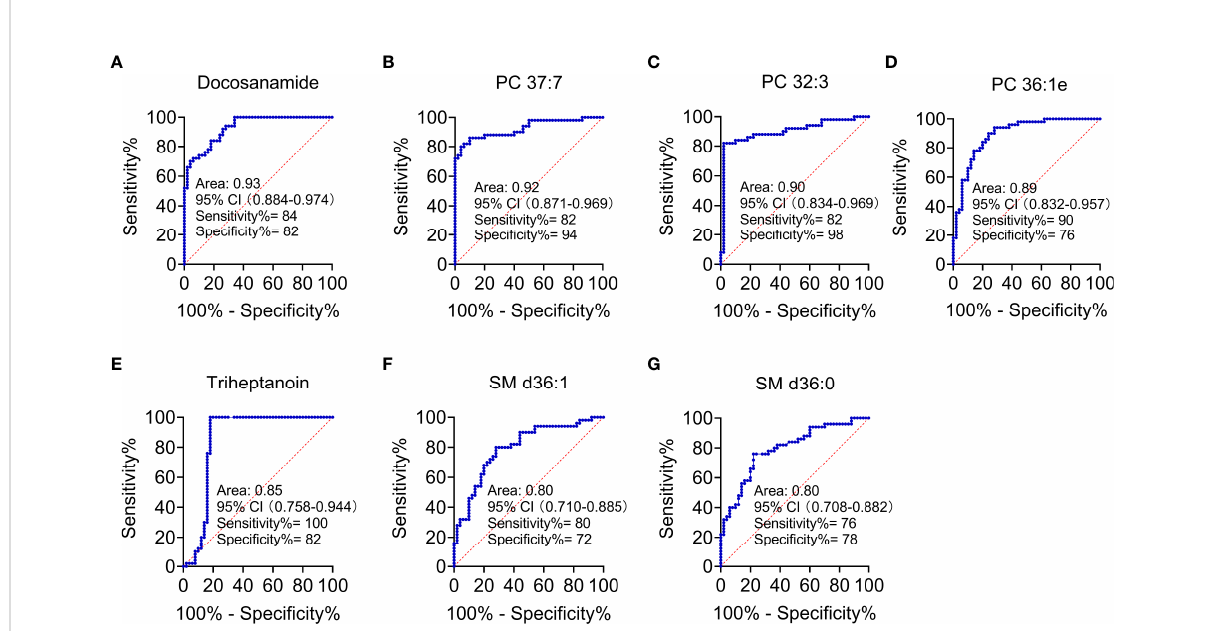
FIGURE 6 Performance evaluation of differential lipid species between CA and CRC groups. Differential lipids between CA and CRC included Docosanamide (A) , PC 37:7 (B) , PC 32:3 (C) , PC 36:1e (D) , Triheptanoin (E) , SM d36:1 (F) , and SM d36:0 (G) with the AUC > 0.80 in ROC analysis.